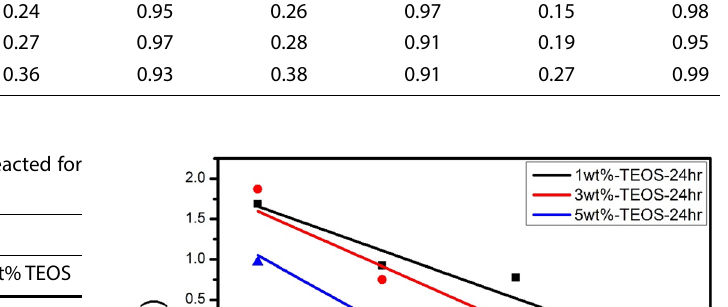
Table 4 Time exponent ( n ) and the goodness-of-fit ( R 2 ) for samples coated with TEOS and reacted for 48 h after soldering at various temperatures